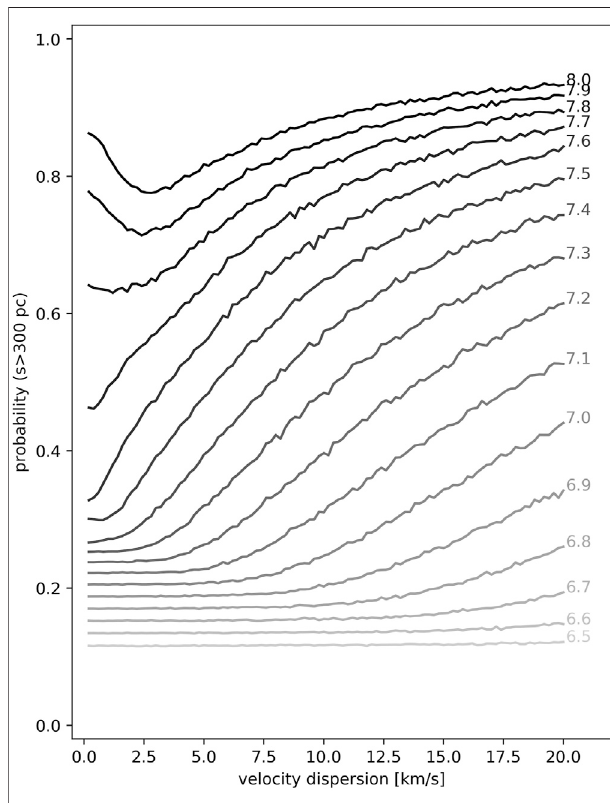
FIGURE 7 | The estimated probability, that a randomly located cluster in a galaxy drifts from the spiral arm (its birthplace), as a function of the velocity dispersion. The simulation was done for multiple cluster ages. Orbital motion basedon therotationcurveoftheMilky Way isalsoincluded.Thecut-off value for Δ s was chosen to be 300 pc. The pattern velocity is Ω p (cid:1) 25 km/s/ kpc. The decrease in the probability for higher ages is due to the fact, that rotation is enough to destroy the spiral structure — the velocity dispersion then slightly increases the chance that some of the clusters will stay near the arm (when compared with the